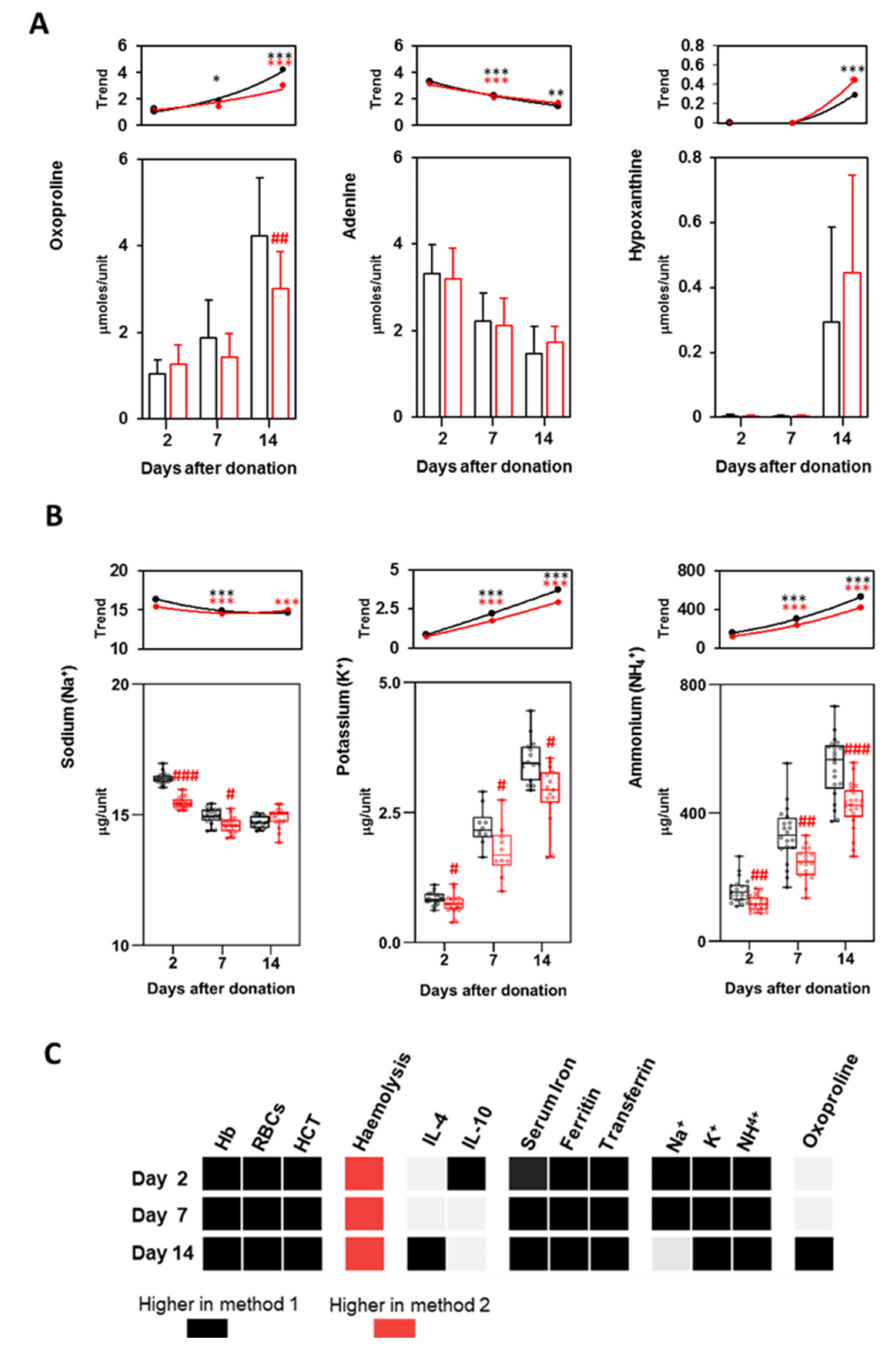
Figure 5. Metabolites and electrolytes comparison at 2, 7 and 14 days after storage. ( A ) Bars of the concentration/unit of oxoproline, adenine and hypoxanthine; ( B ) Box plots with single values of the concentration/unit of K + and NH 4+ . Points and lines in the top panels of both ( A , B ) indicate differences between consecutive time points, as described in Figure 2. Method 1 is in black, method 2 in red. The boxplots were prepared as described in Figure 2. Red # indicate significant differences between the two methods at the various time points. # p < 0.05, ## p < 0.01 and ### p < 0.001. * indicate significant differences of the same method at two consecutive time points. * p < 0.05, ** p < 0.01 and *** p < 0.001; ( C ) Summary scheme of the significant different parameters between the two methods at all the time points